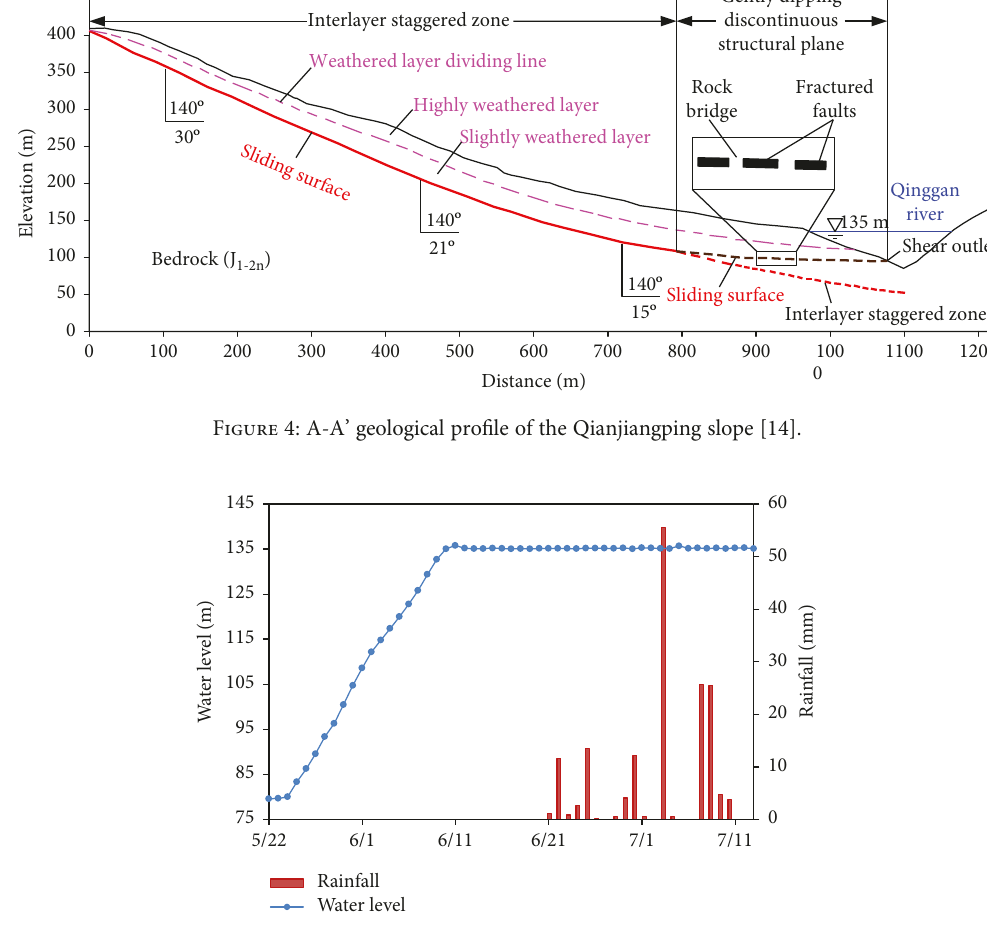
Figure 5: The impounding process of the TGR and the rainfall process in the slope region before the slope failure [6].